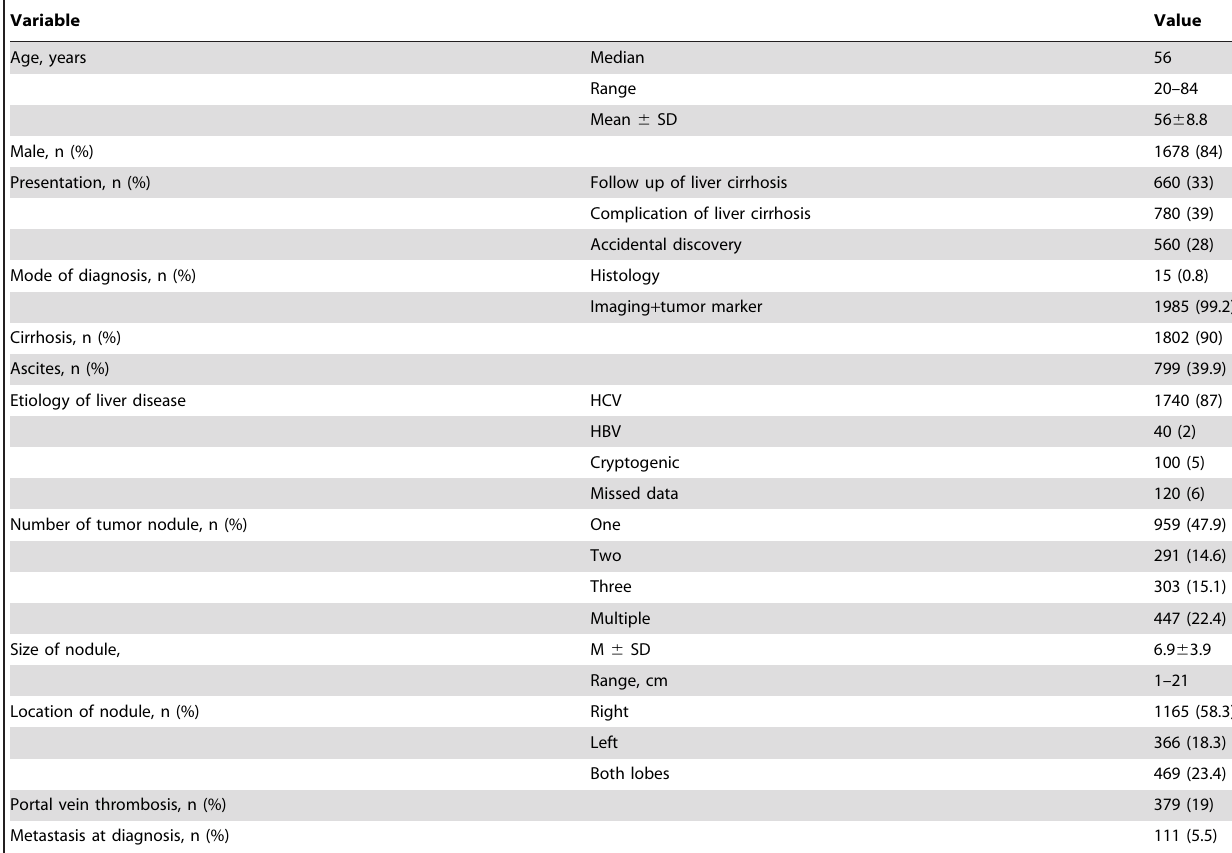
Table 1. Characteristics of all patients included in the